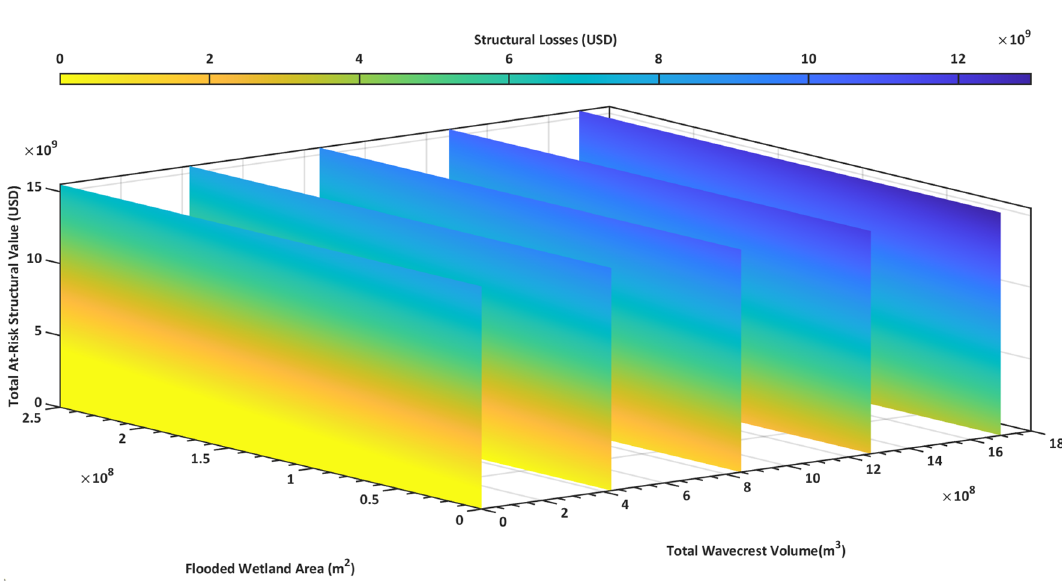
Figure 6. NJ county structural loss regression model. An ordinary least squared linear regression model. Constructed using the flooded wetland area, total at-risk structural value, and total wavecrest volume as predictors to estimate structural losses in zip-codes (R2 = 0.85, p =